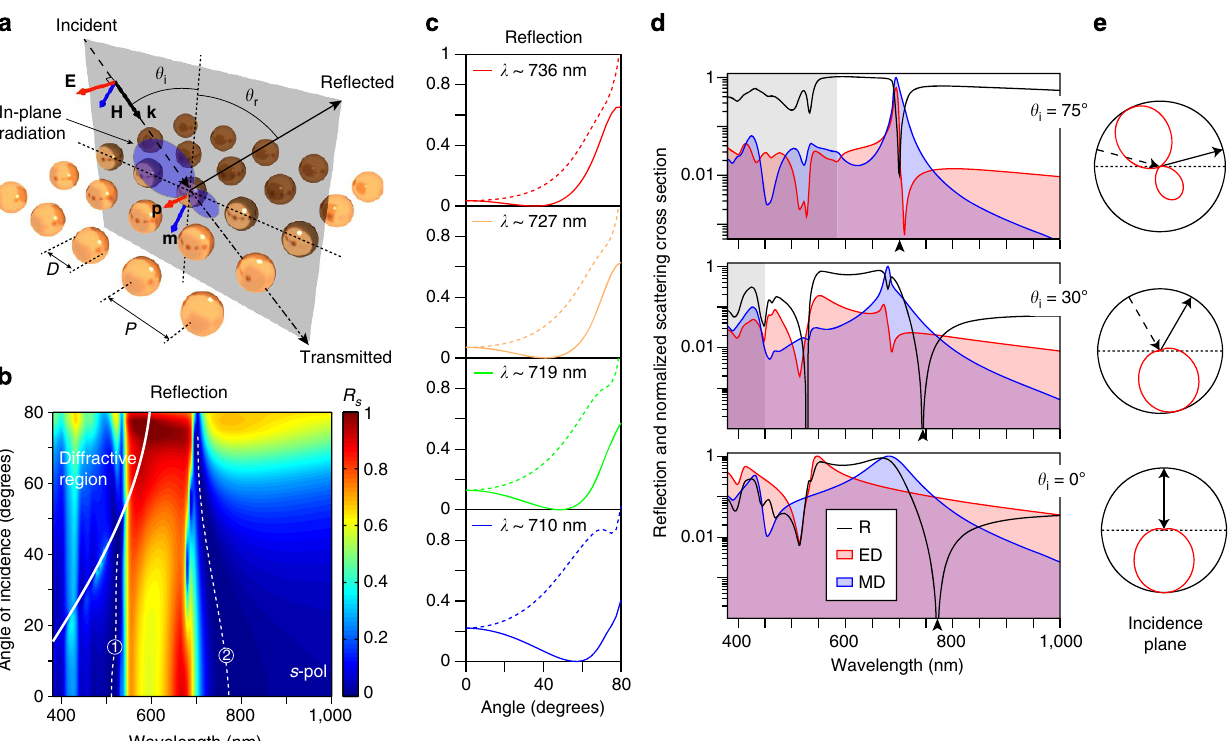
Figure 4 | Simulated optical response of arrays of silicon spheres under s -polarized oblique incidence. ( a ) Scheme of the simulated system. ( b ) Numerically calculated reflection versus wavelength and angle of incidence for a square array of silicon spheres with diameter D ¼ 180nm and pitch P ¼ 300nm. The region for which diffraction appears is indicated and delimited by the thick, solid white line. The white dashed lines are guides to the eye to help identifying the low reflectivity regions of interest. ( c ) Reflection versus angle of incidence for selected wavelengths showing Brewster’s angle for s -polarization. Solid lines represent s -polarization while dashed lines are the corresponding curves for p -polarization. Dependence on wavelength and the possibility to achieve values below 45 (cid:2) are observed. ( d ) Reflection (black curve) and electric dipole (red curve and corresponding shaded area, electric dipole (ED)) and magnetic dipole (blue curve and corresponding shaded area, magnetic dipole (MD)) contributions to the scattering (normalized to their common maximum) from a single sphere in the array for several angles of incidence. Log 10 scale is used for better visualization of the minima. Diffractive regions are indicated by the shaded grey area. ( e ) Associated radiation patterns of each single particle in the array in the plane of incidence at the wavelengths of minimum reflection (arrow heads in d